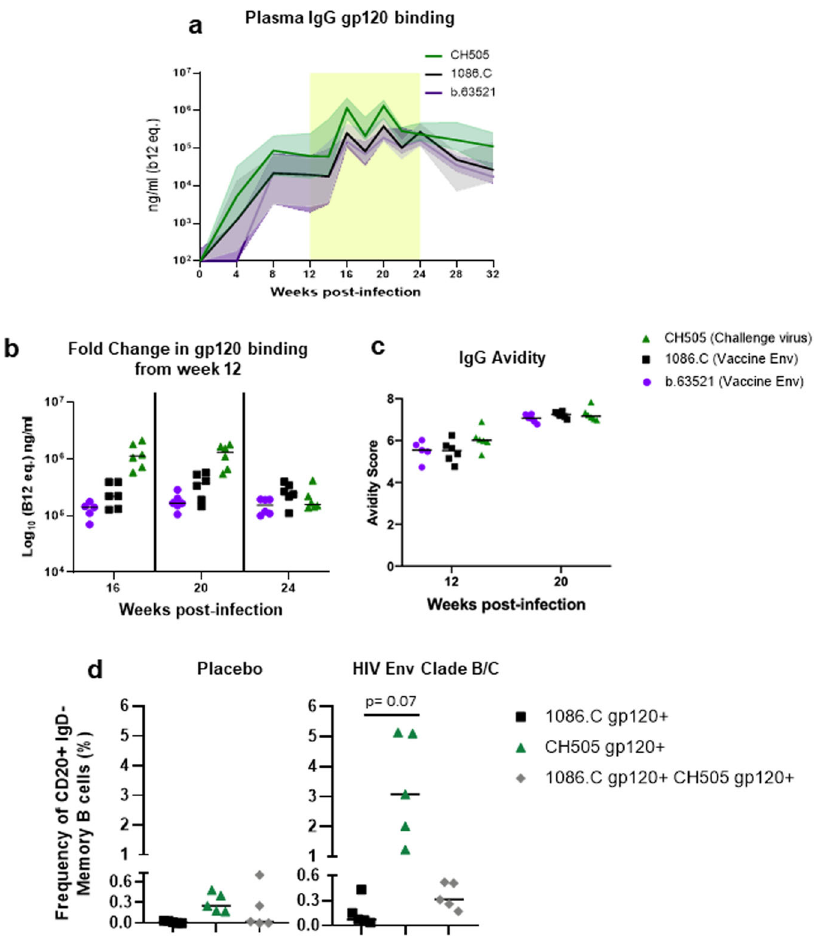
Fig. 5 Heterologous Env vaccination boosts pre-existing autologous Env-speci fi c B cell responses compared to vaccine-speci fi c responses among vaccinated RMs- evidence for antigenic seniority. IgG binding responses speci fi c for vaccine and challenge virus antigens were compared among Env vaccinated RMs ( a ). To evaluate changes in IgG binding responses among the vaccinated cohort across all three antigens, the fold change ( b ) from week 12 (pre-ART/immunization) were compared for each antigen at 16, 20, and 24 wpi (2 weeks post each immunization). Antibody avidity, measured by SPR, across all three antigens were also compared among vaccinees ( c ). Frequency of CH505 and 1086.C gp120-speci fi c memory B cells at week 24 post-infection in HIV Env vaccinated and placebo recipient RMs ( d ). Each data point represents one animal, and medians are indicated as horizontal lines. Statistical analyses were performed using Wilcoxon signed-rank tests with exact p -values to compare Env vaccinated RMs ’ plasma CH505 gp120 IgG binding and avidity responses, and Env vaccinated RMs ’ CH505 gp120-speci fi c memory B cells to 1086.C and b.63521-speci fi c responses, followed by FDR adjustments for multiple comparisons. See Supplementary Table 5 for unadjusted p and FDR_p for all